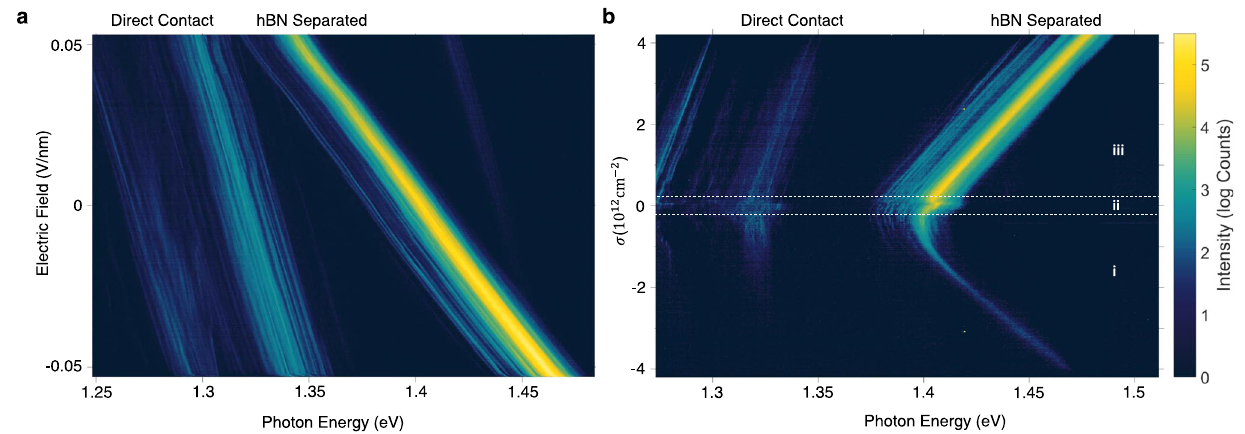
Fig. 2 | IX photoluminescence as a function of electric fi eld and doping level. a PLemissionasafunctionofelectric fi eldmeasuredbyexcitingthehBNseparated regionwhilecollectingfrombothregions.ThehBNseparatedIXlinesshowalarger